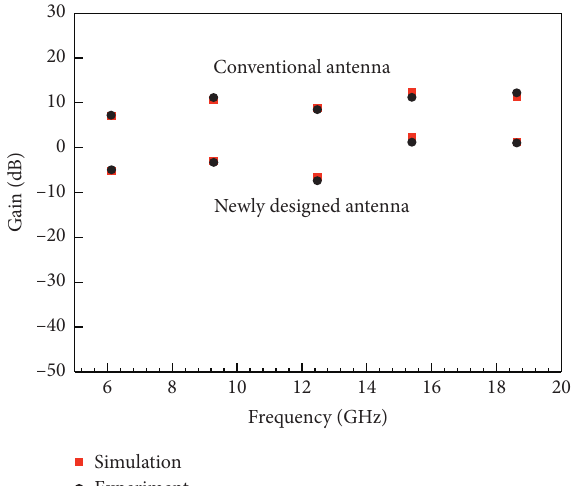
Figure 10: Comparison of the simulated and measured peak gains at the harmonic resonance modes of the conventional patch antenna and newly designed patch antenna. Table 2: Comparison between this work and references.